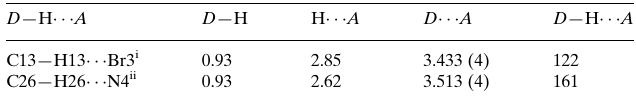
Hydrogen-bond geometry (A˚ , (cid:2) ). D —H (cid:3)(cid:3)(cid:3)